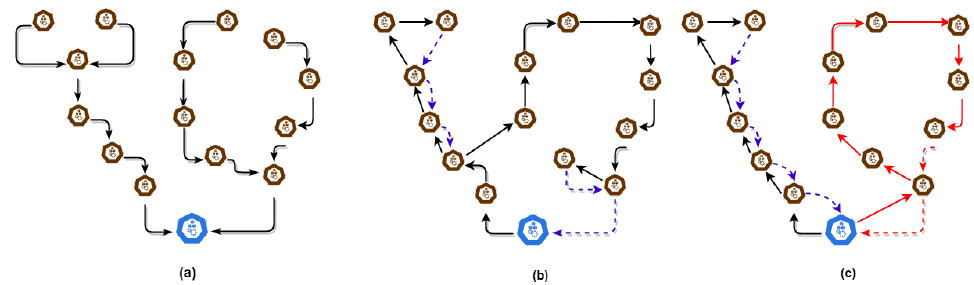
Figure 4. ( a ) Centralized data aggregation, ( b ) Single Itinerary Planning (SIP), and ( c ) Multiple Itinerary Planning